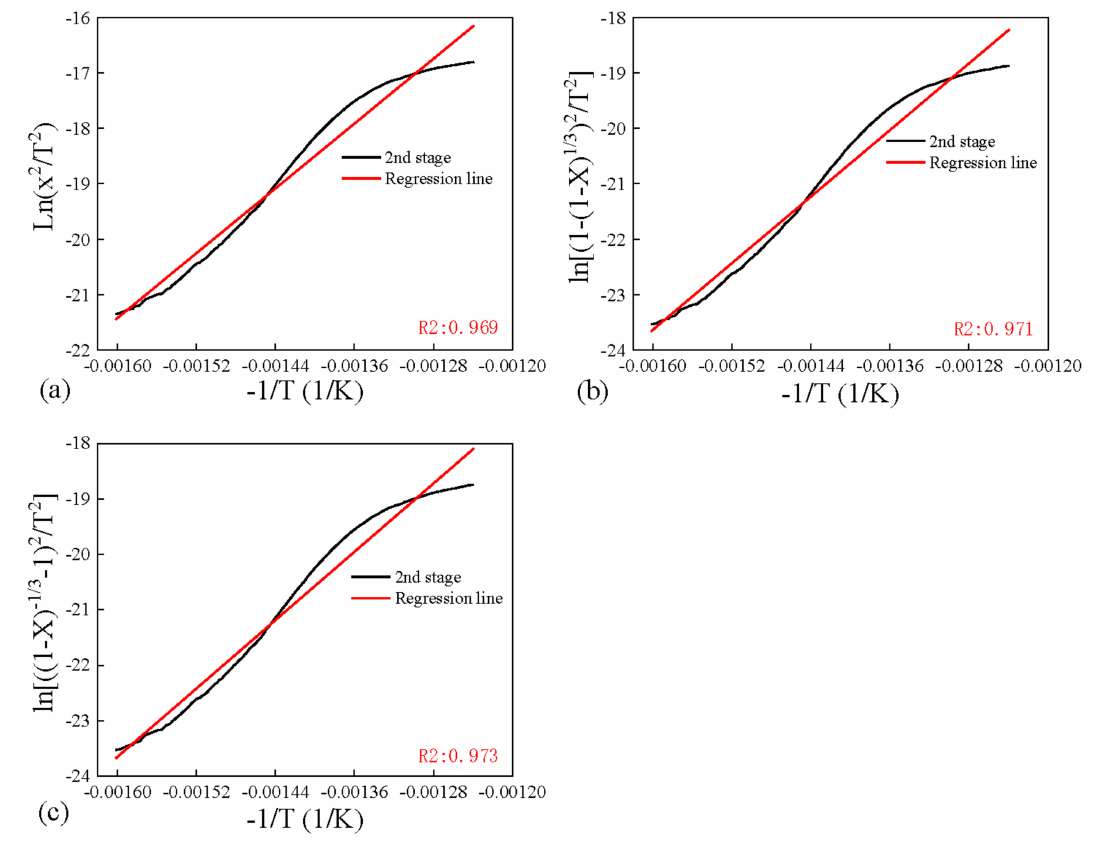
Figure 9. Models obtained by applying Coats–Redfern method for C-YL, ( a ) Diffusion C, ( b ) Diffusion D, ( c ) Diffusion